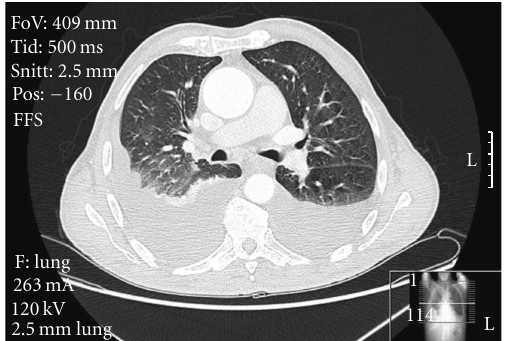
Figure 2: Chest computerized axial tomography shortly after the admission in the hospital.